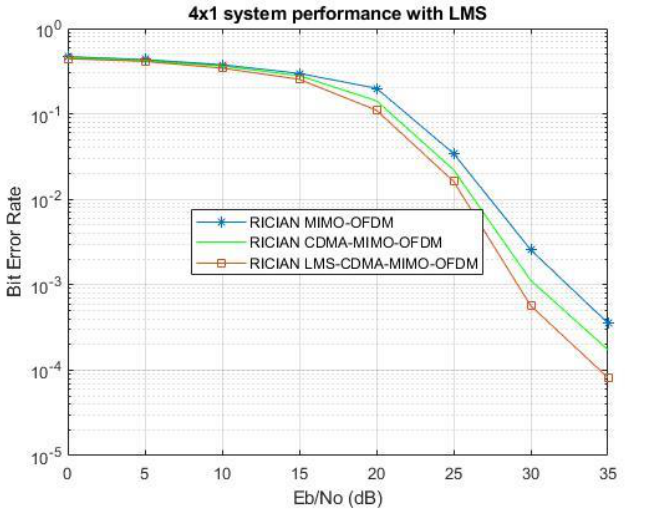
Figure 16. SNR vs. BER plot for 4×1 LMS-MIMO-OFDM model in Rician